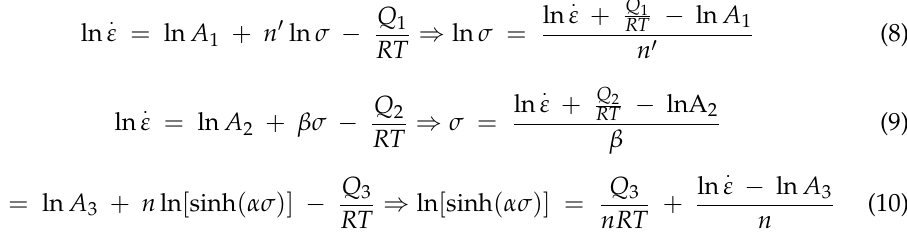
Figure 7. Relationships among different parameters: ( a ) 𝑙𝑛𝜎 ‐ 𝑙𝑛𝜀(cid:4662) ; ( b ) 𝑙𝑛𝜎 ‐ 1/T; ( c ) 𝜎 ‐ 𝑙𝑛𝜀(cid:4662) ; ( d ) 𝜎 ‐ 1/T; ( e ) 𝑙𝑛𝑠𝑖𝑛ℎ(cid:4666)𝛼𝜎(cid:4667) ‐ 𝑙𝑛𝜀(cid:4662) ; ( f ) 𝑙𝑛𝑠𝑖𝑛ℎ(cid:4666)𝛼𝜎(cid:4667) ‐ 1/T. Table 4. Detailed fitted parameters of AP model under different strain rates at RT and 630 °C. Parameters